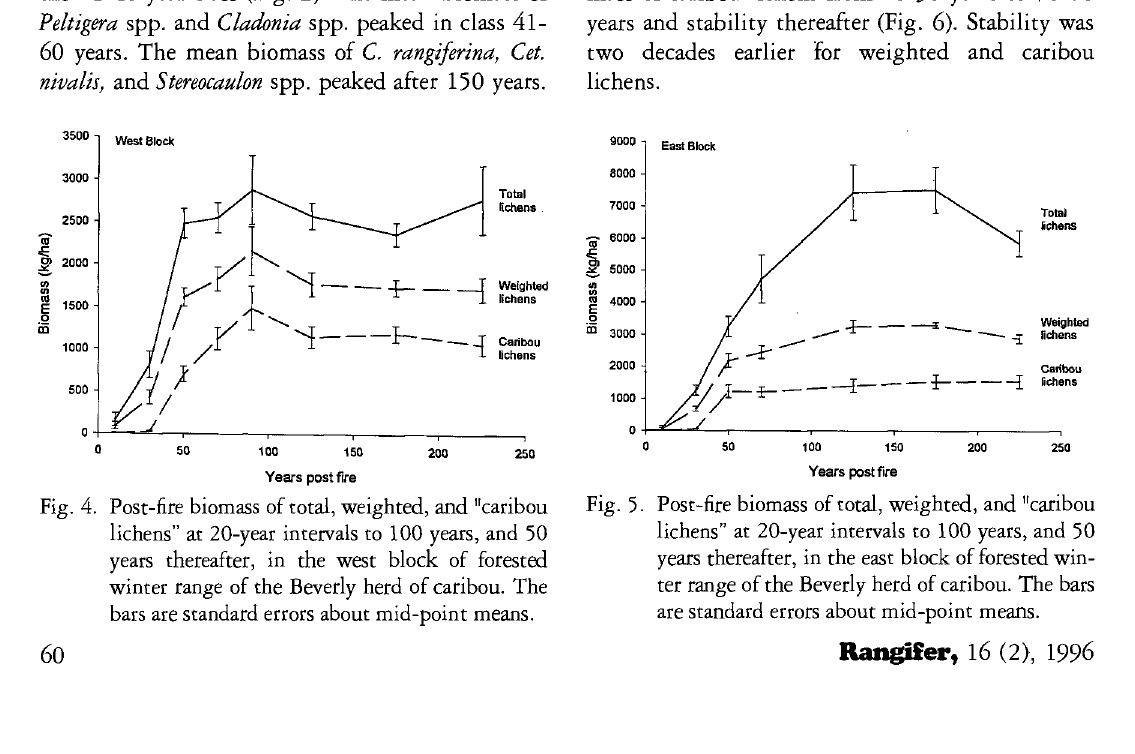
Fig. 5. Post-fire biomass of total, weighted, and "caribou lichens" at 20-year intervals to 100 years, and 50 years thereafter, in the east block of forested win ter range of the Beverly herd of caribou. The bars are standard errors about mid-point